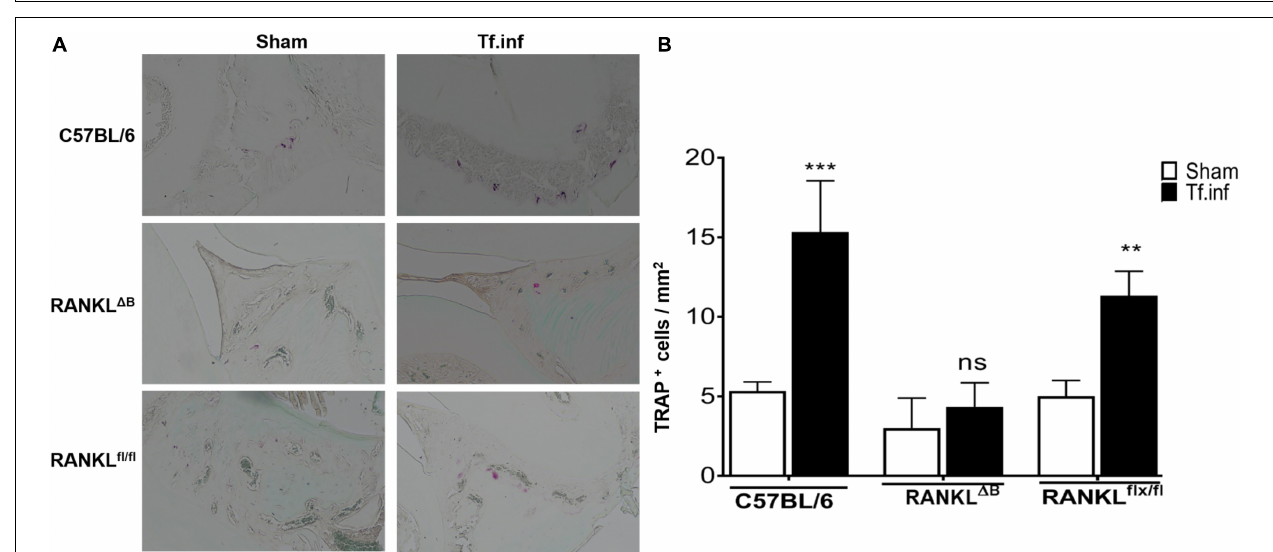
FIGURE 5 | Deletion of RANKL in B cells attenuates T. forsythia induced alveolar bone loss. Mice were infected by oral gavage with 6 doses (10 9 cells/dose) of either T. forsythia (10 9 cells/dose; Tf WT) or sham-infected and alveolar bone levels were determined. (A) Alveolar bone destruction was assessed by measuring the distance from the ABC to the CEJ at 14 maxillary buccal sites per mouse ( n = 8). (A) Total alveolar bone loss per group was calculated by averaging total CEJ-ABC distances (14 sites per mouse) of all mice. (B) The net bone loss, calculated as mean total ABC-CEJ distance of T. forsythia infected group minus mean total ABC-CEJ distance of the sham-infected group, show that the net bone loss caused by T. forsythia is significantly higher in RANKL fl / fl mice than RANKL (cid:49) B mice. (C) Representative images of maxillae from each group stained with methylene blue and imaged with a Nikon SMZ 1000 microscope (original magnification X3). Bars indicate means and standard deviations. ∗∗∗ p < 0.001.